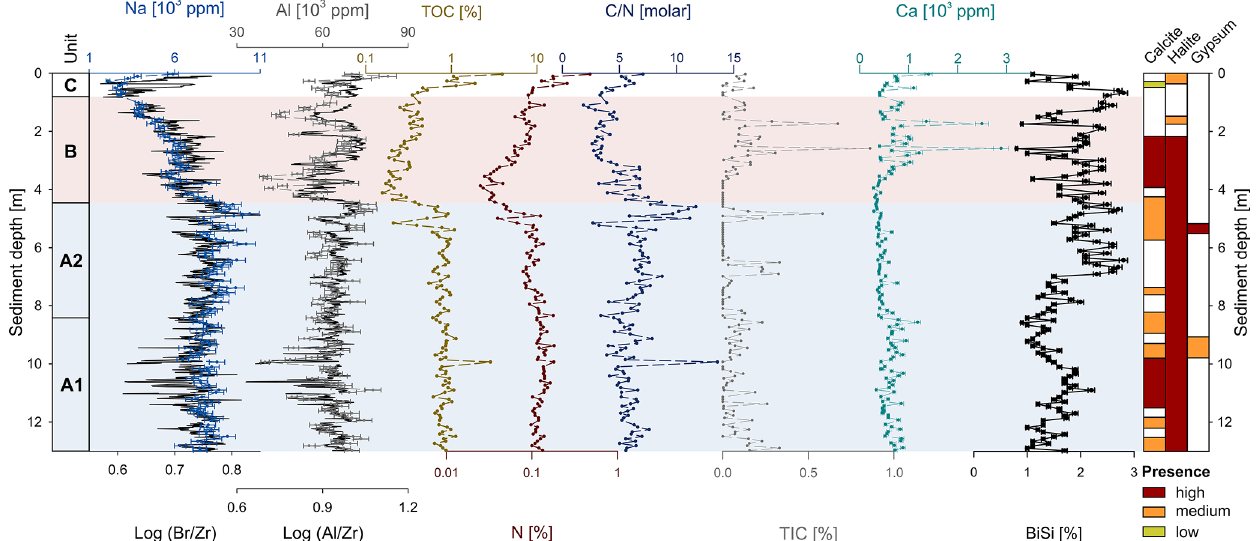
Figure 3. Lithological units, sodium (Na) content and Log 10 ratio of bromine (Br) and zirconium (Zr), aluminium (Al) and Log 10 ratio of Al and Zr, contents of total organic carbon (TOC), total nitrogen (N), molar C / N ratio, total inorganic carbon (TIC), calcium (Ca), and biogenic silica (BiSi) derived from the sediment core VOV16 from Voëlvlei. The presence of selected mineral components is also depicted.